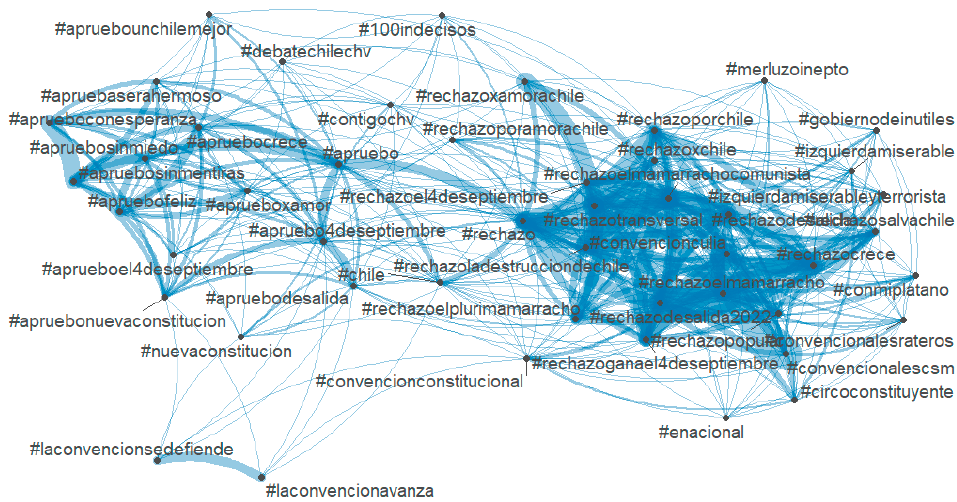
Figure 2. Network of hashtags with hate speech for Apruebo Dignidad 2022 .